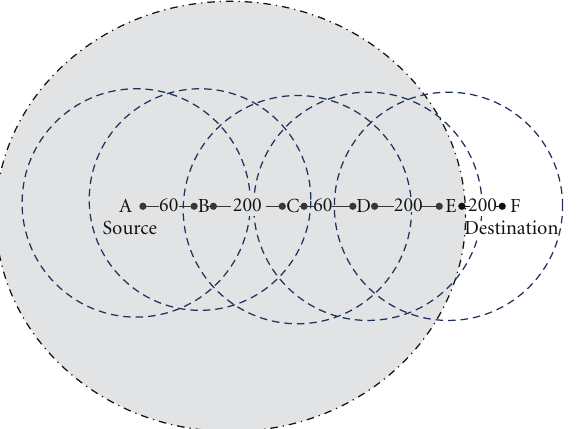
Figure 9: Example 2: A is the source node and F is the destination node. The carrier sensing range of node A is shown as shaded area. Here, the transmission distance between the nodes AB, BC, CD, DE, and EF are modified as 60m, 200 m, 60 m, 200m, and 200m, respectively.